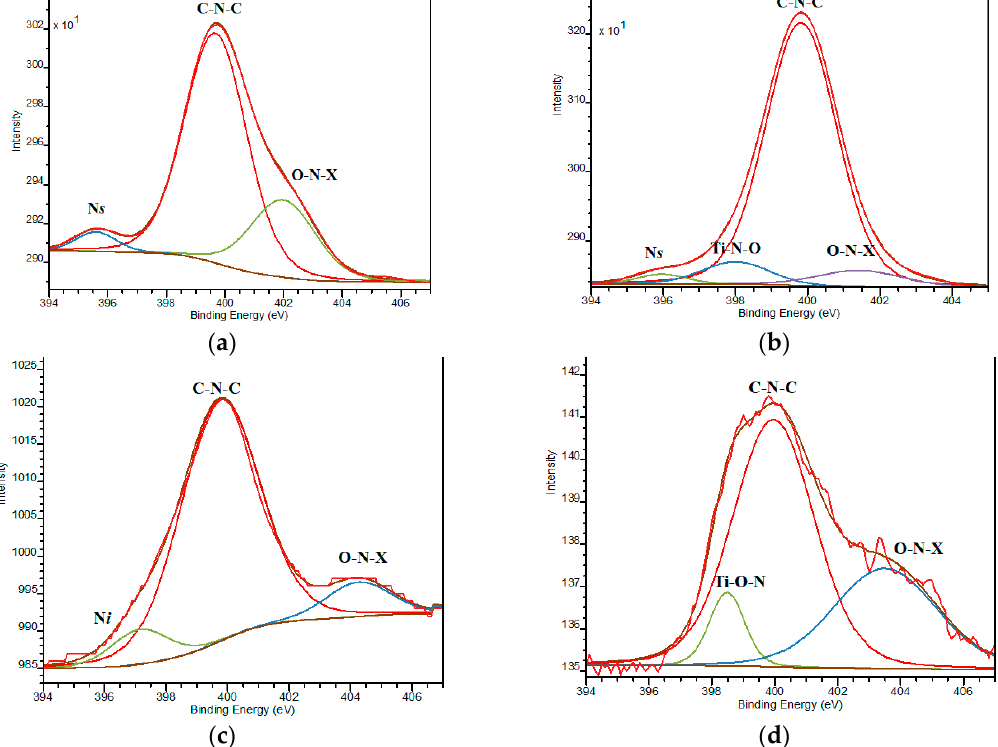
Figure 5. XPS N1s deconvoluted lines: ( a ) 1Pt,N-TiO 2M1 ; ( b ) 1Pt,N-TiO 2M2 ; ( c ) 1Pt,N-TiO 2M1UV ; ( d ) 1Pt,N-TiO 2M2UV .